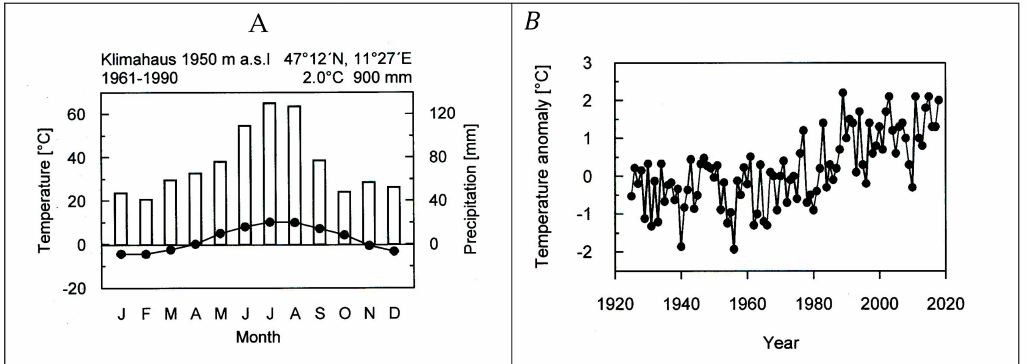
Figure 1. ( A ) Climate diagram (mean monthly temperature in lines and mean monthly precipitation in bars) and ( B ) temporal variation in mean annual air temperature during the period 1925–2018 relative to the 1961–1990 average at the treeline on Mount Patscherkofel. Compiled after [45] and